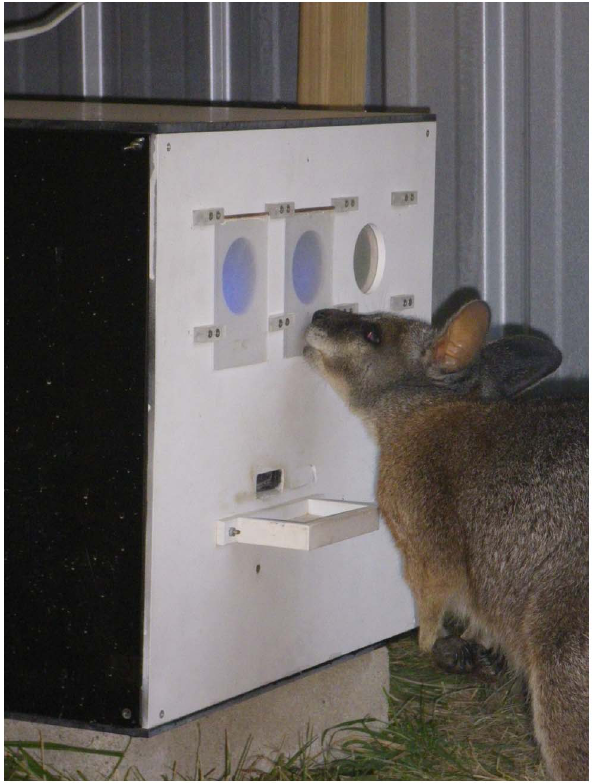
Figure 1. Wallabies readily used the automated operant conditioning setup for colour vision experiments. Light stimuli were projected onto diffuser flaps that also served as the trigger when the animal pushed to indicate a stimulus choice. If correct, a food reward was delivered into a feeder bowl under the stimuli. Photo copyright: W.